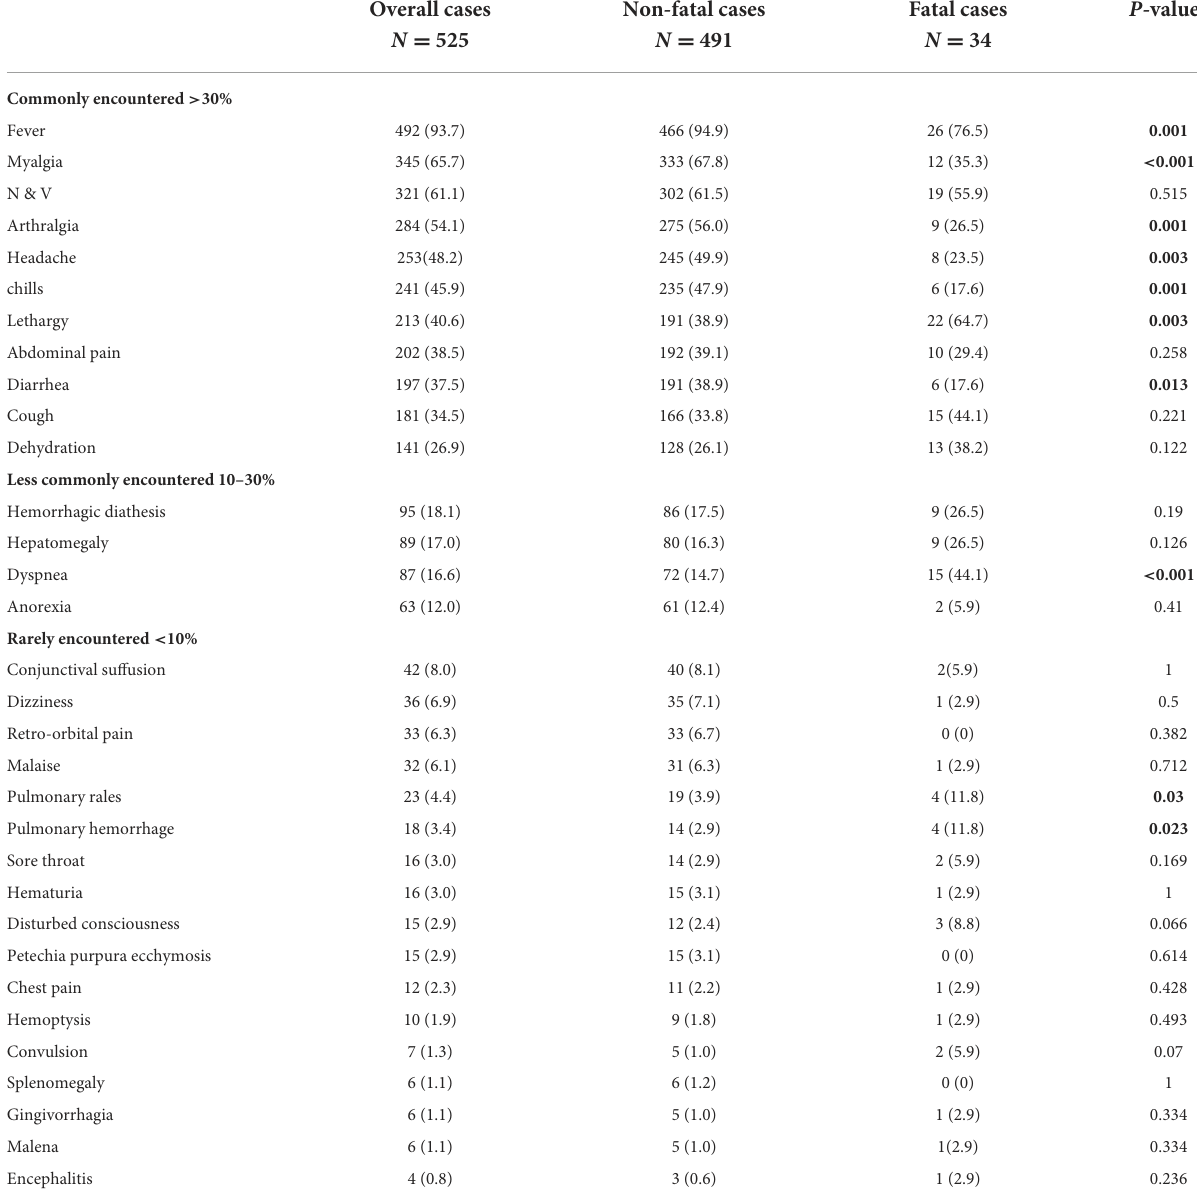
TABLE 6 Comparison of clinical manifestation (at baseline) between fatal and non-fatal leptospirosis patients.